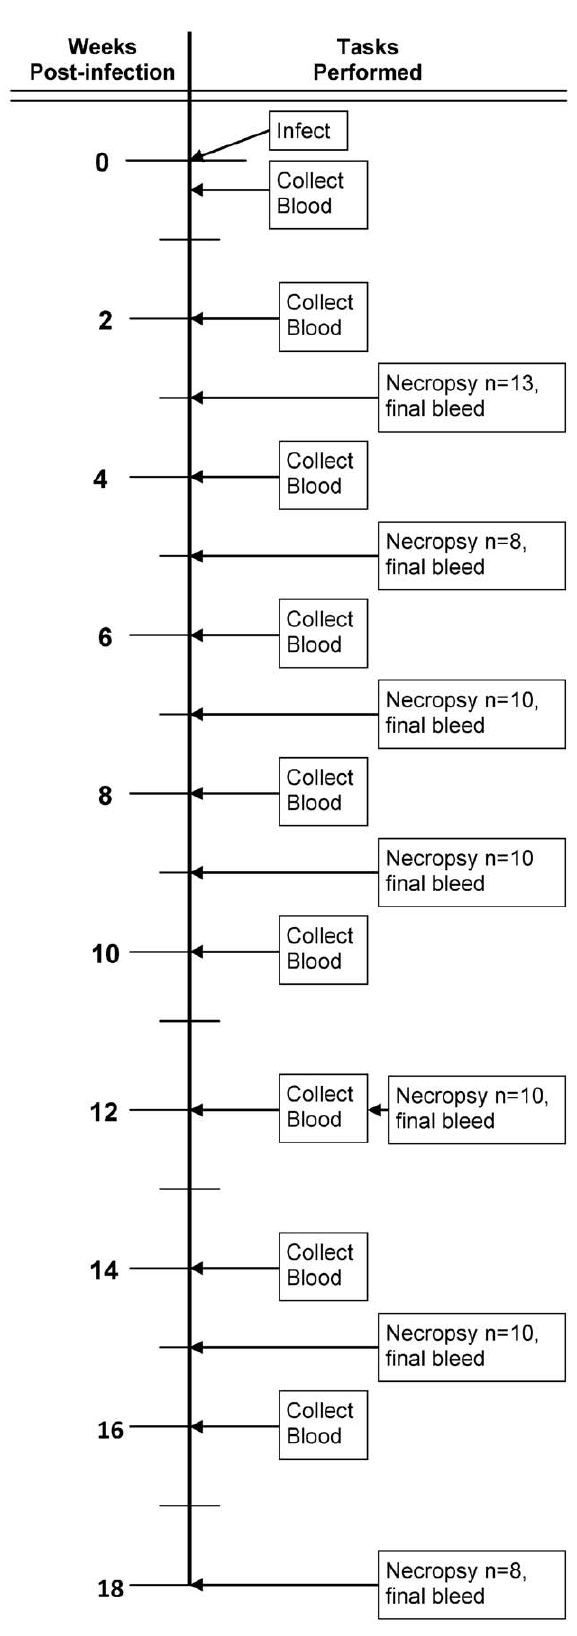
Figure 1. Experimental design showing the chronology of sampling